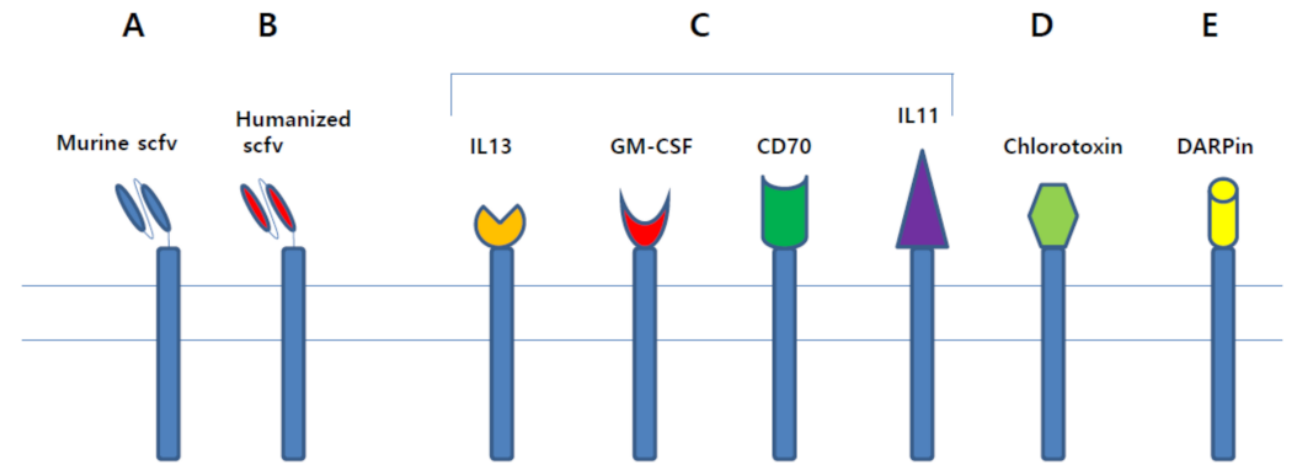
Figure 3. Various antigen binding domains. ( A ) In early days of CAR T cell research, murine scFv was used as antigen binding domain. ( B ) To avoid disadvantages of murine scFv, humanized scFv was used in recent research. ( C ) Natural ligands, such as IL13, GM-CSF, CD70, and IL11, can be used for antigen binding domain. ( D ) As chlorotoxin can bind to most primary glioblastoma cells, toxin-based CAR T cells were developed. ( E ) Designed ankyrin repeat proteins (DARPin), which are composed of repeating ankyrin motifs, can be used for antigen binding domain.